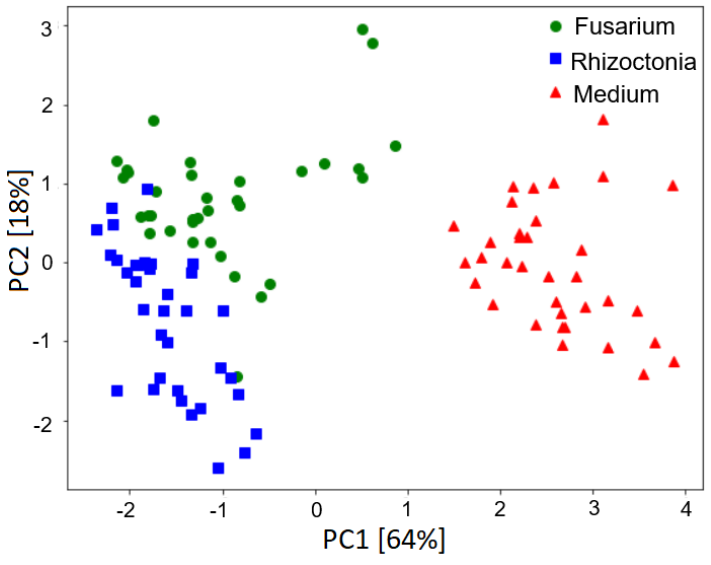
Figure 4. Distribution of measured samples based on PCA transformation of the modelling features extracted from sensor response curves. Data were obtained from the PW6 e-nose, all TGS 2603 sensors; six features selected by the classification model were transformed. The sample types are represented with different colours and symbols. The percentages of variability accounted for by the PC are indicated on the axes’ labels.